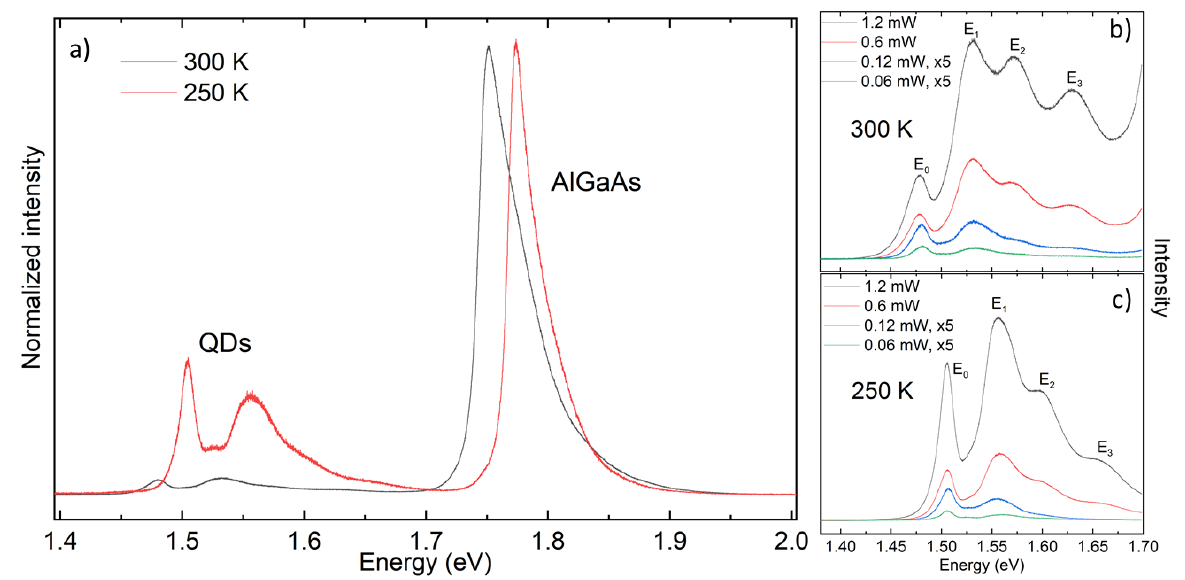
Figure 5. PL data from a type III sample taken with a green laser (532 nm). ( a ) PL spectrum at T R (black) and 250K (red) with 0.06mW excitation power; strong QD peaks are visible. ( b ) Zoom of QD spectra at T R and ( c ) at 250K, taken at different laser powers as indicated. The ground state and up to 3 excited states are clearly visible. The intensity is normalized for equal peak intensities of the luminescence from the AlGaAs